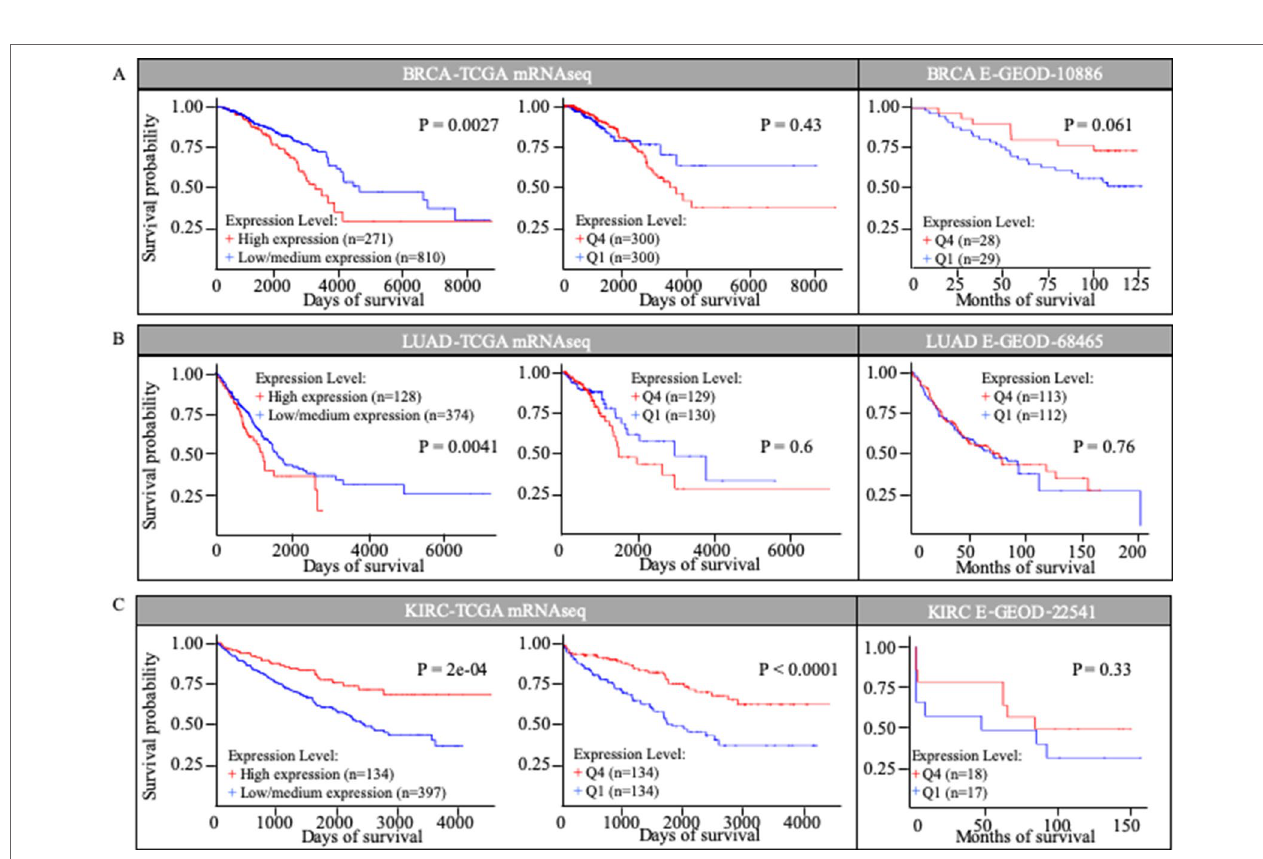
FIGURE 2 | Kaplan-Meier survival curves in TCGA cohorts and E-GEOD data sets. Survival curves based on MuD expression was plotted for breast invasive carcinoma (BRIA) (A) , lung adenocarcinoma (LUAD) (B) , and kidney renal clear cell carcinoma (KIRC) (C)